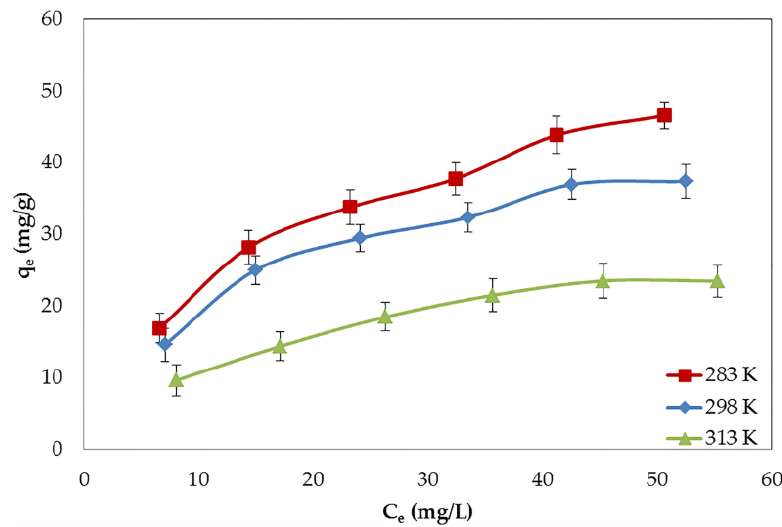
Figure 5. Effect of temperature on the adsorption of BPA by GO.